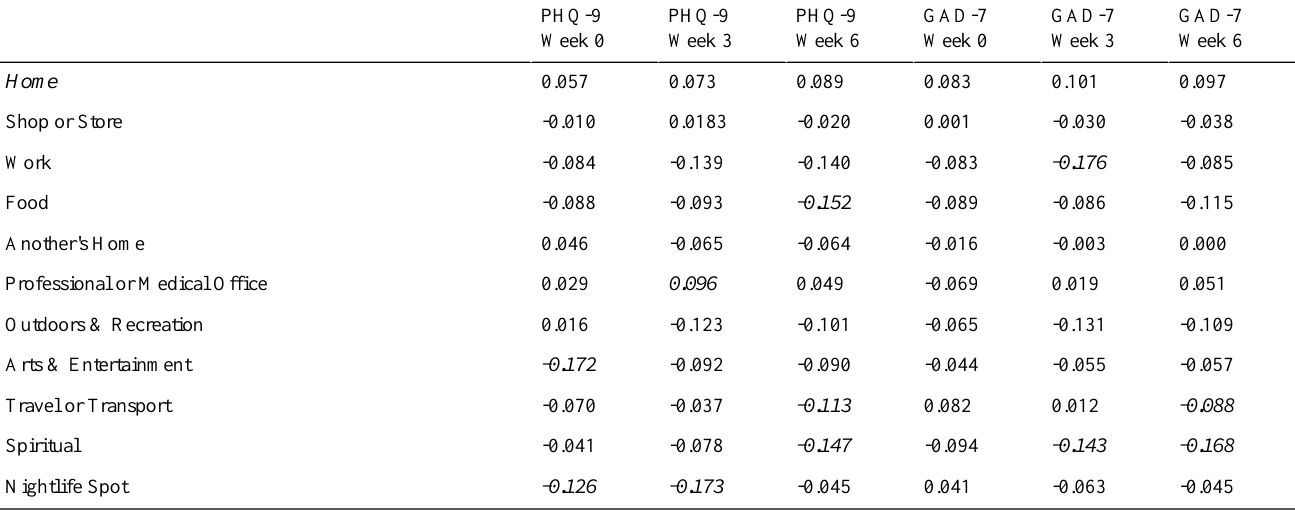
Table 3. Linear correlation coefficients ( r ) between time spent at semantic locations and depression (PHQ-9) and anxiety (GAD-7) scores. Values show the median of 1000 bootstrap estimates of r . Italicized values indicate coefficients that are significantly ( P &lt;.05) different from zero. However, by correcting for multiple comparisons (66 comparisons here) we cannot rule out the possibility that these correlations are a result of